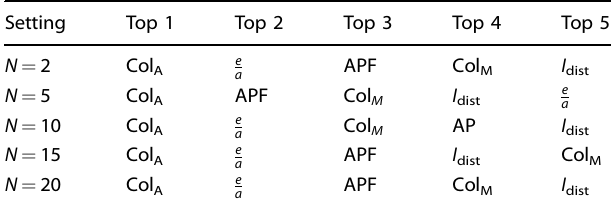
Table 6. The top 5 important factors selected by BART for the maximum bulk modulus K in MAX phases with additional non- informative features with the initial set of sample size N ∈ {2, 5, 10, 15, 20} using